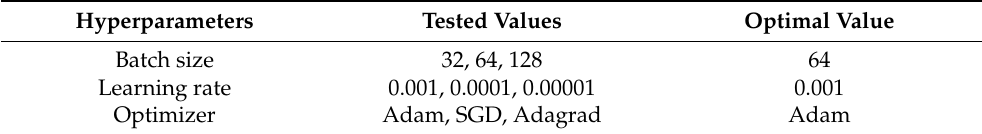
Table 5. Summary of hyperparameter tuning.